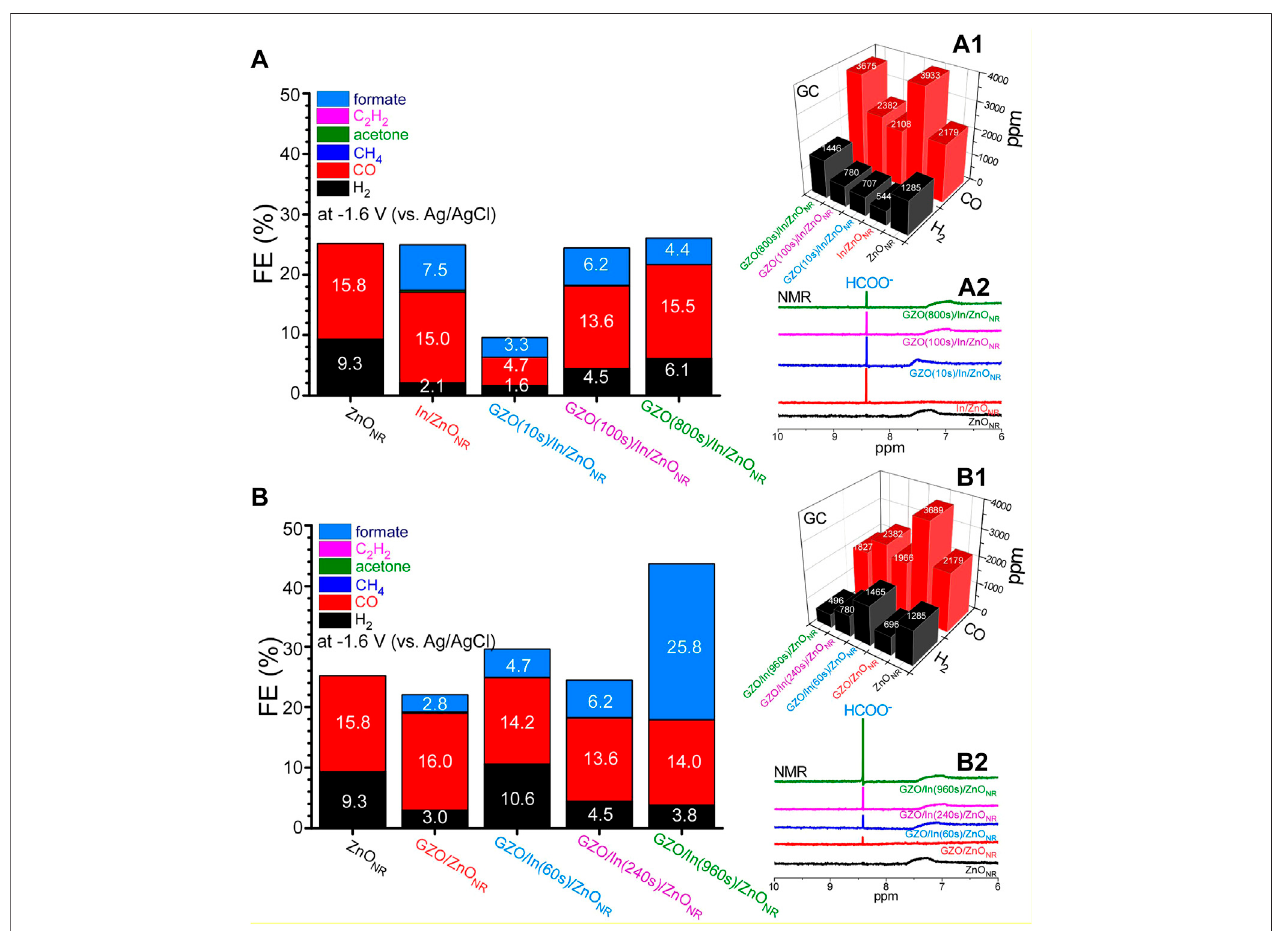
FIGURE 3 | Electrochemical CO 2 reduction FE(%) (A) , ppm amounts of H 2 and CO (A1) , and the corresponding NMR data (A2) for ZnO NR , In(240s)/ZnO NR , and GZO/In(240s)/ZnO NR with GZO thicknesses of 10, 100, and 800 s at − 1.6 V (vs. Ag/AgCl). FE (%) (B) , ppm amounts of H 2 and CO (B1) , and the corresponding NMR data (B2) for ZnO NR , GZO(100s)/ZnO NR , GZO(100s)/In/ZnO NR with In thicknesses of 60, 240, and 960 s at − 1.6 V (vs.